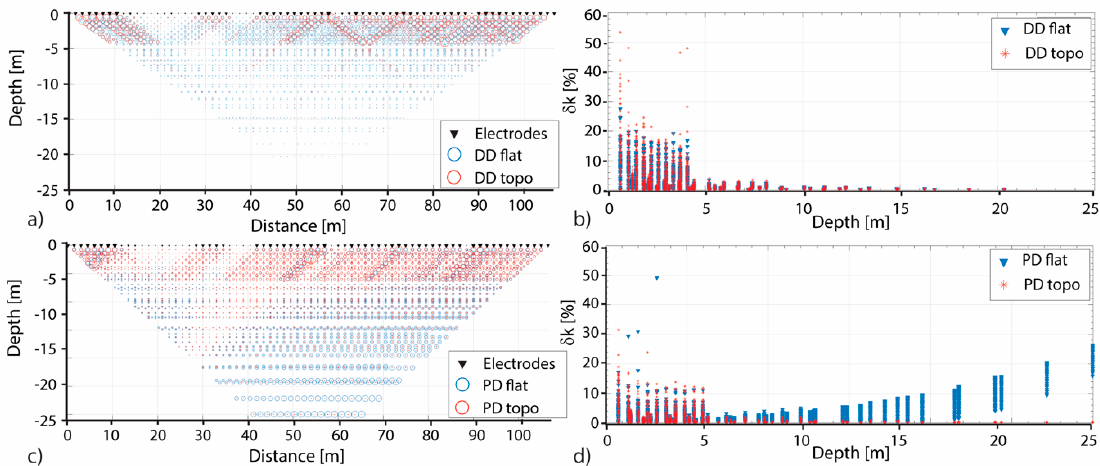
Figure 6. Distributions for the DD and PD arrays of the errors in the geometric factor ( δ k). In ( a ) and ( c ) for each quadripole the δ k is the radius of a circle, while in ( b ) and ( d ) the δ k numerical values are plotted versus the depth. In all the panels blue represents the δ k values for the flat solution, while red that for the topography one.